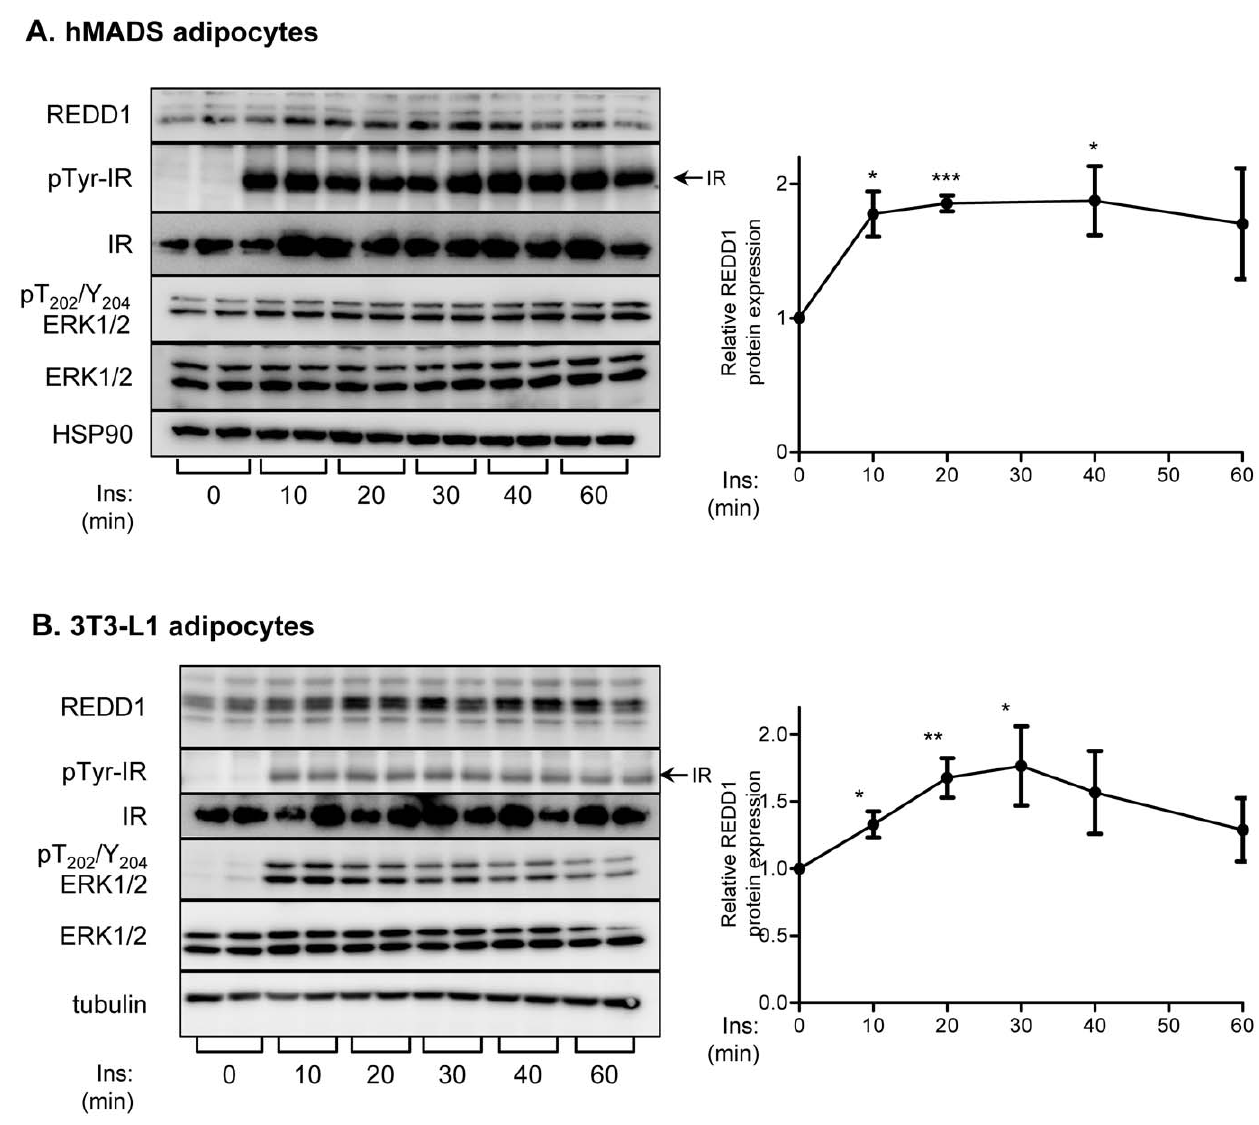
Figure 1. Insulin stimulates REDD1 expression in human and murine adipocytes. hMADS adipocytes (A) and 3T3-L1 adipocytes (B) were stimulated with insulin (100 nM) for the indicated period of times and analyzed by immunoblots with indicated antibodies. Quantification of three independent experiments done in duplicate is shown and REDD1 protein level is expressed compared to HSP90 or tubulin expression (*p , 0.05; **p , 0.01, ***p , 0.001).